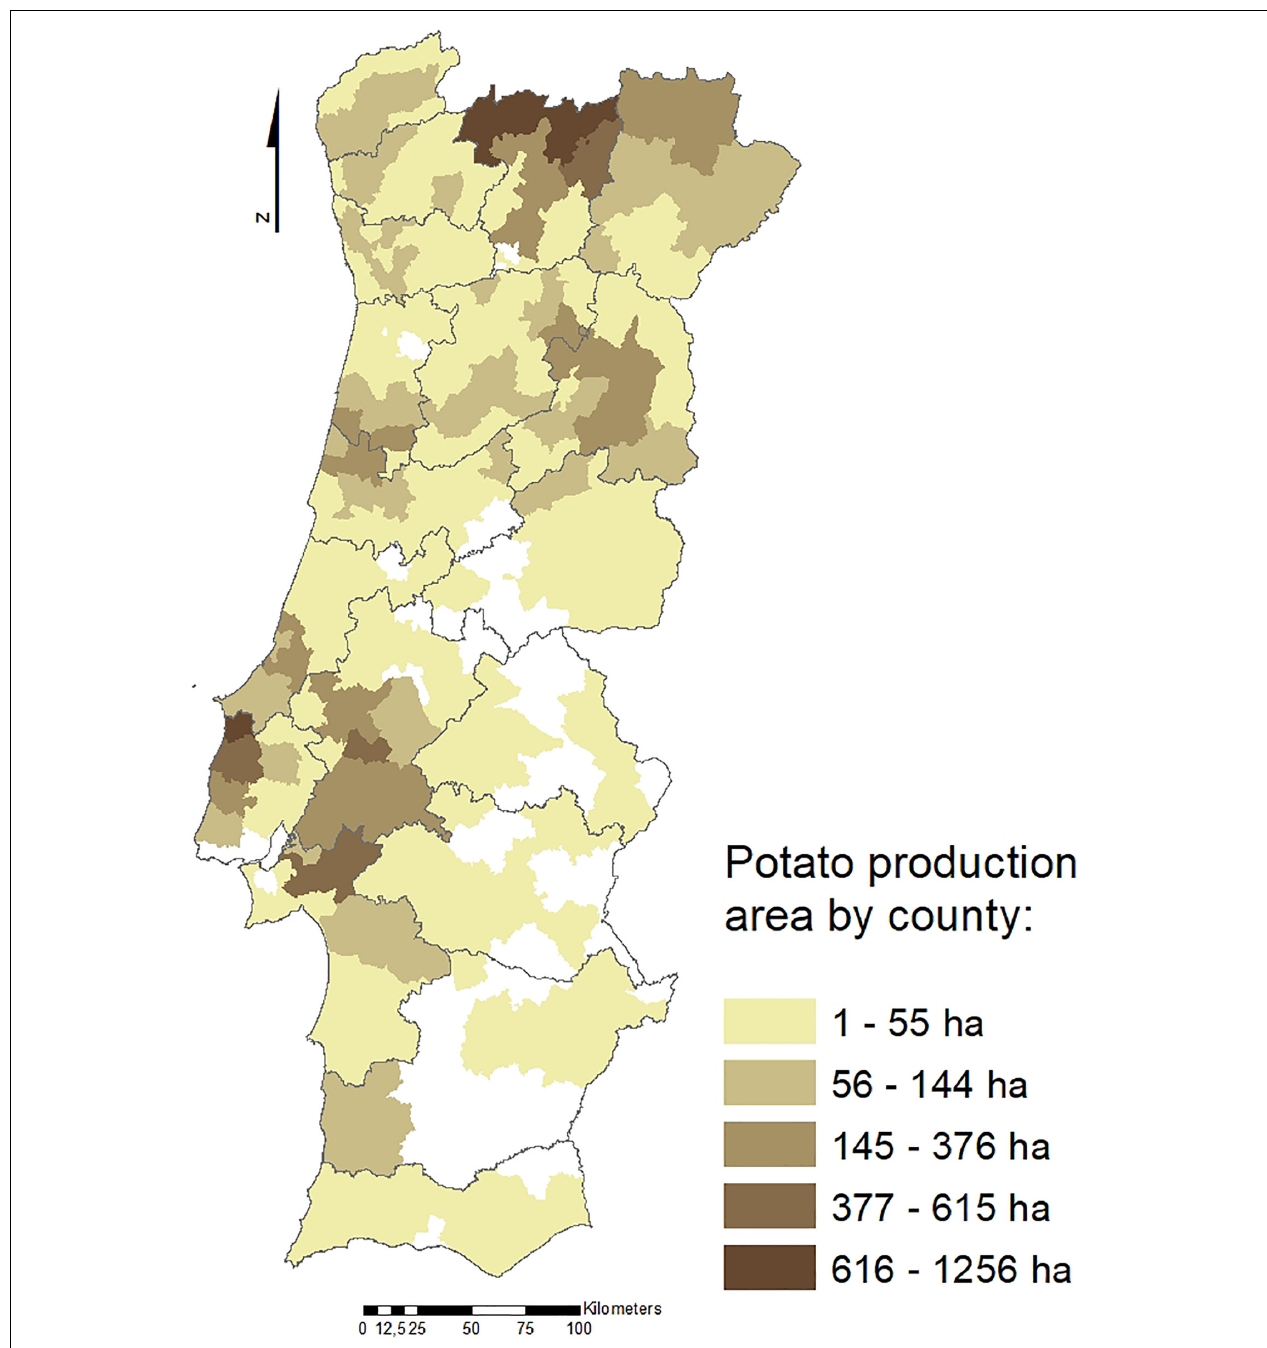
FIGURE 1 | Potato production areas (ha) in Portugal by county (data from INE,